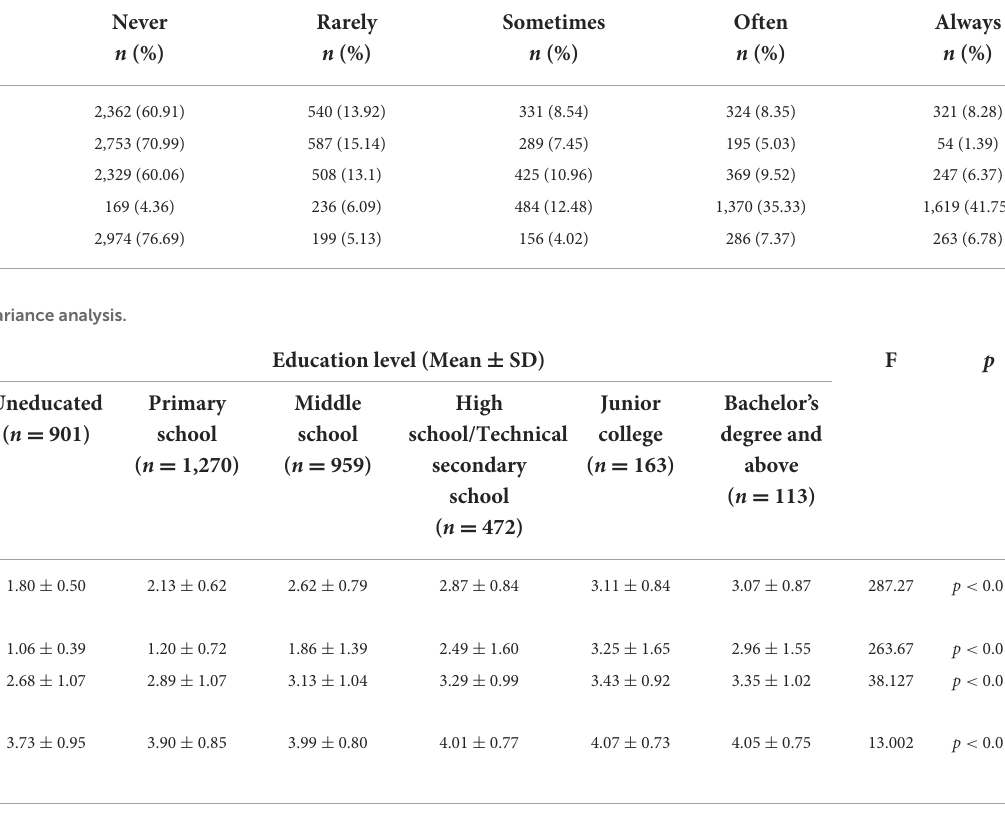
TABLE 2 Descriptive statistics of participants’ media use ( N = 3,878).